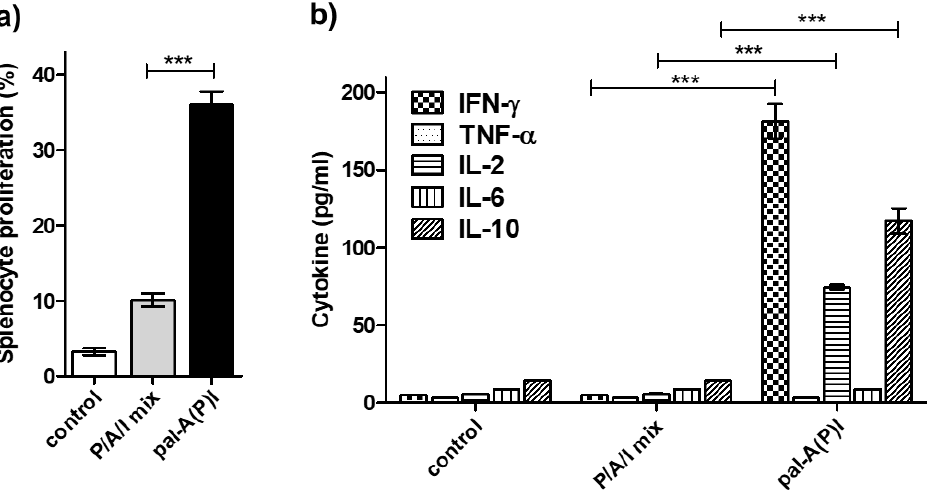
Figure 4. Immunogenicity of the compounds . ( a ) The provoked immune response was characterized in a T-cell proliferation assay, and ( b ) the cytokine response was measured by using a LEGENDplex bead-based immunoassay. Data represented as mean ± SEM are percent population of proliferated splenocytes ( a ) and pg/mL amount of cytokines ( b ) (n = 3 mice/group). (***: p < 0.001; TNF-α and IL- 6: not